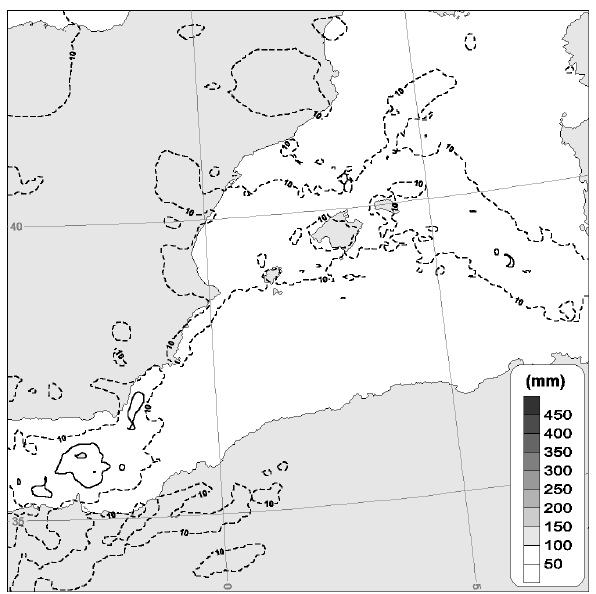
Fig. 16. As in Fig. 7c but for the weakened cutoff low precursor